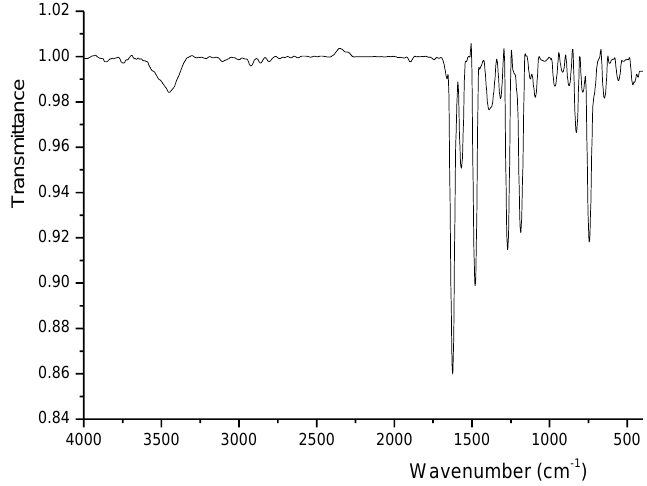
Fig. S1. IR spectrum of H